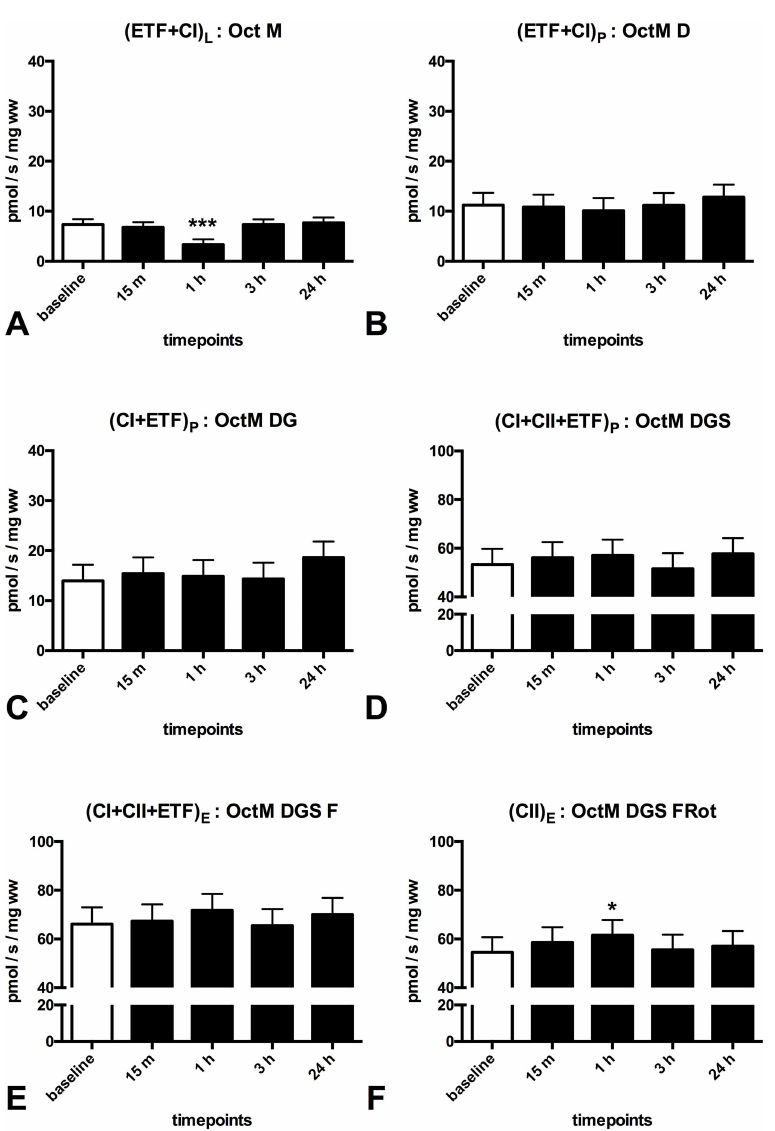
Fig 3. Effect of one session of calf raises upon mitochondrial respiration in patients with PVD. Mitochondrial respiration(pmol O 2 /s/ mg wet weight of muscle fibers) in patients with PVD comparedto at baseline. (A) (ETF+CI)L is the LEAK state electron transfer through electron transferring flavoprotein (ETF) and complex I after addition of the substrates octanoylcarnitin (0.2mM) + malate (2mM), in the absence of ADP (B) : (ETF+CI)P is fatty acid oxphos capacity after addition of ADP (2.5mM) (C) : (CI+ETF) P is electron transfer through complex I and ETF reaching complex I oxphos capacity after addition of glutamate (10mM) (D) : (CI+II+ETF)P is electron transfer through complex I, II and ETF reaching complex I and II oxphos capacity after addition of succinate (10mM) and ADP (5mM) (E) : (CI+II+ETF)E is electron transfer through complex I, II and ETF reaching ETS capacity after FCCP titrations (0.5M max. 3M) to uncoupleoxidation from phosphorylation (F) : (CII) E is ETS capacity supportedby complex II after addition of rotenone (0.5M), which inhibits complex I. The subscripts L,P,E indicate the LEAK state, OXPHOS and ETS capacity. Oct (0.2mM octanoylcarnitin), M (2mM malate), D (2.5mM ADP),G (10mM glutamate), S (10 mM succinate), D (5mM ADP), F (0.5M FCCP titrations) Rot (0.5 M Rotenon).White (baseline);black (pst-exercise). Values are mean and standard error of the mean, n = 11. * Significantly different from pre (P < 0.05), ** Significantly different from pre (P < 0.01), *** Significantly different from pre (P <